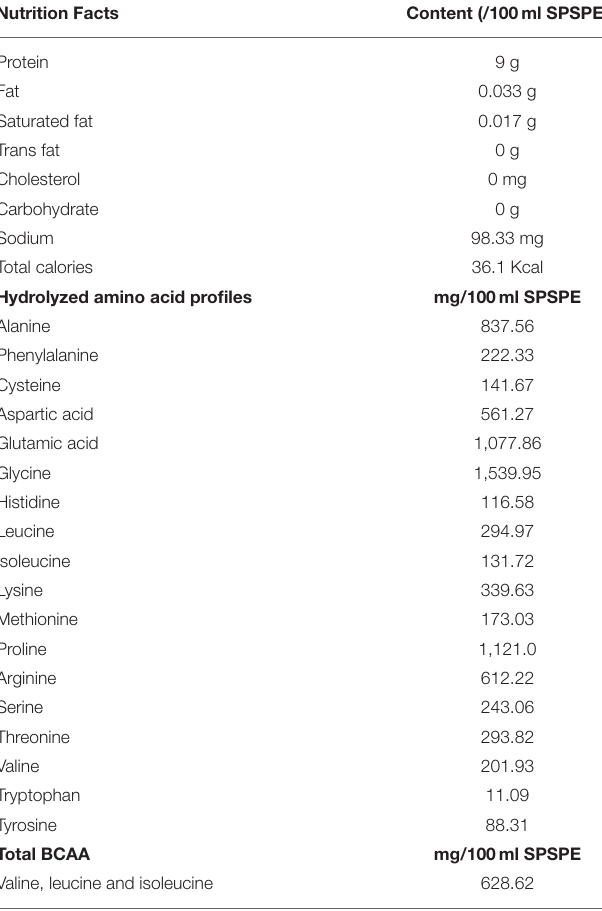
TABLE 1 | Nutrition facts, hydrolyzed amino acid profiles and total branched-chain amino acids of fish essence. Nutrition